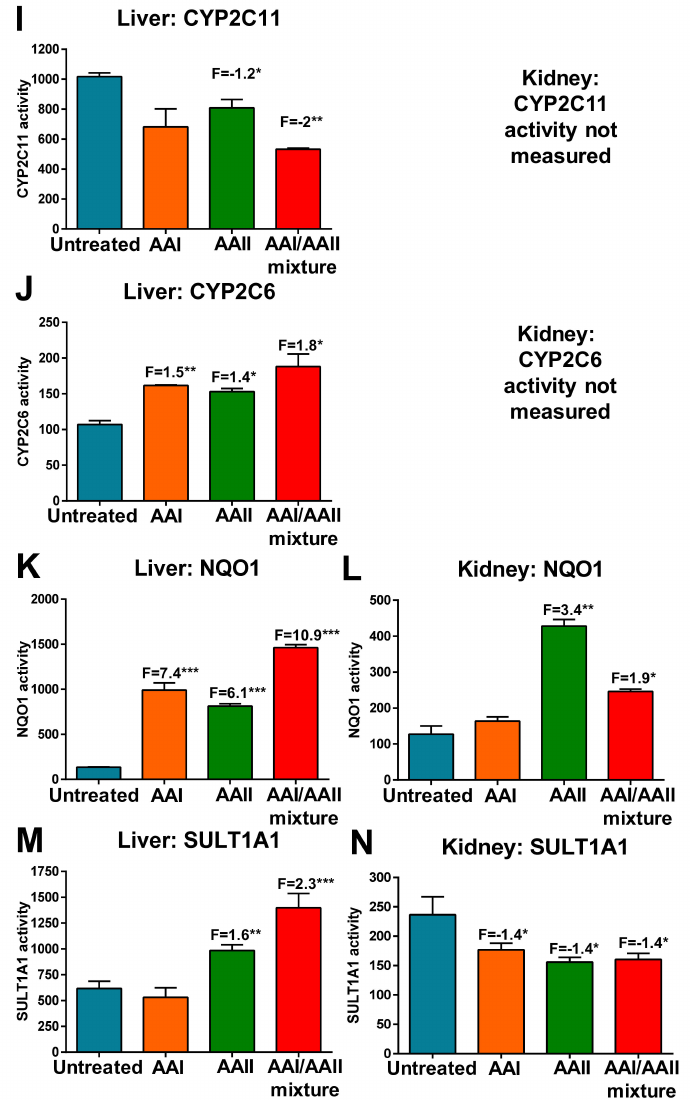
Figure 3. Measurement of enzyme activity levels in microsomal and cytosolic fractions of livers (left panels) and kidneys (right panels) from control (untreated) rats and rats treated with AAI, AAII, or AAI/AAII mixture. CYP1A enzymatic activity in microsomal fractions as measured by EROD activity (picomoles resorufin per minute per milligram protein) ( A , B ), MROD activity (picomoles re- sorufin per minute per milligram protein) ( C , D ) or Sudan I oxidation (picomole total C-hydroxylated metabolites per minute per milligram protein) ( E , F ). POR enzyme activity was measured as nmol of cytochrome c /mg/minute ( G , H ). CYP2C11 enzyme activity was measured as testosterone 16 α - hydroxylation (picomoles 16 α -hydroxytestosterone per minute per milligram protein) ( I ). CYP2C6 enzyme activity was measured as diclofenac 4 (cid:48) -hydroxylation (picomoles 4 (cid:48) -hydroxydiclofenac per minute per milligram protein) ( J ). CYP2C11 and CYP2C6 activity was only measured in hepatic microsomes. NQO1 enzyme activity was determined using menadione and cytochrome c as the substrate and expressed as nanomoles cytochrome c /minutes/mg protein ( K , L ). SULT1A1 enzyme activity was determined using a colorimetric assay with p -nitrophenol sulfate as the sulfo-donor and is expressed as picomoles p -nitrophenol/minute/mg protein ( M , N ). All values are given as the means ± SD ( n = 3). Numbers above columns (‘F’) indicate fold changes in enzyme activity levels compared to control (untreated). Comparison was performed by t -test analysis: * p < 0.05, ** p < 0.01, *** p < 0.001, differences from control. Note different scaling when comparing enzymatic activity levels in hepatic and renal microsomal or cytosolic